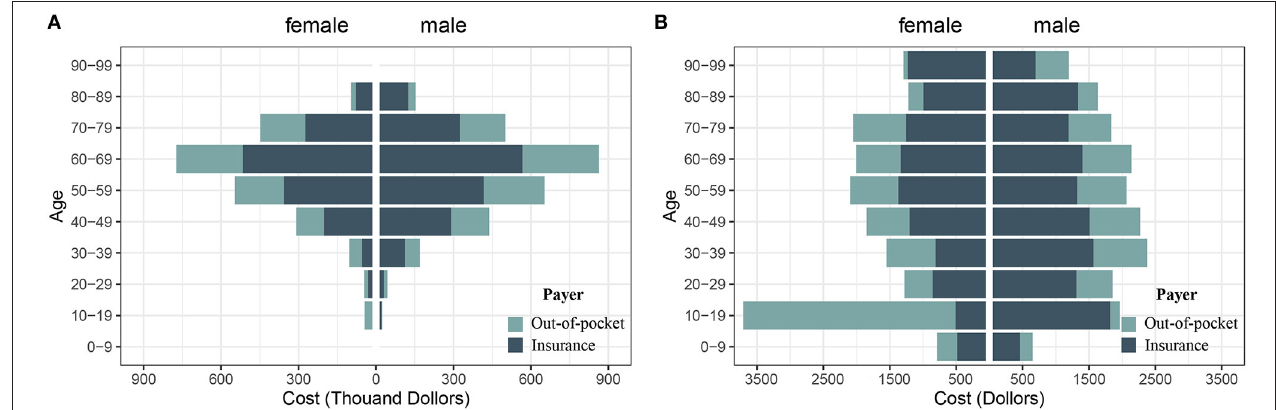
FIGURE 2 | Pyramid diagram to describe the distribution of costs by sex and age group. (A) Cost at population level; (B) Cost at individual level.